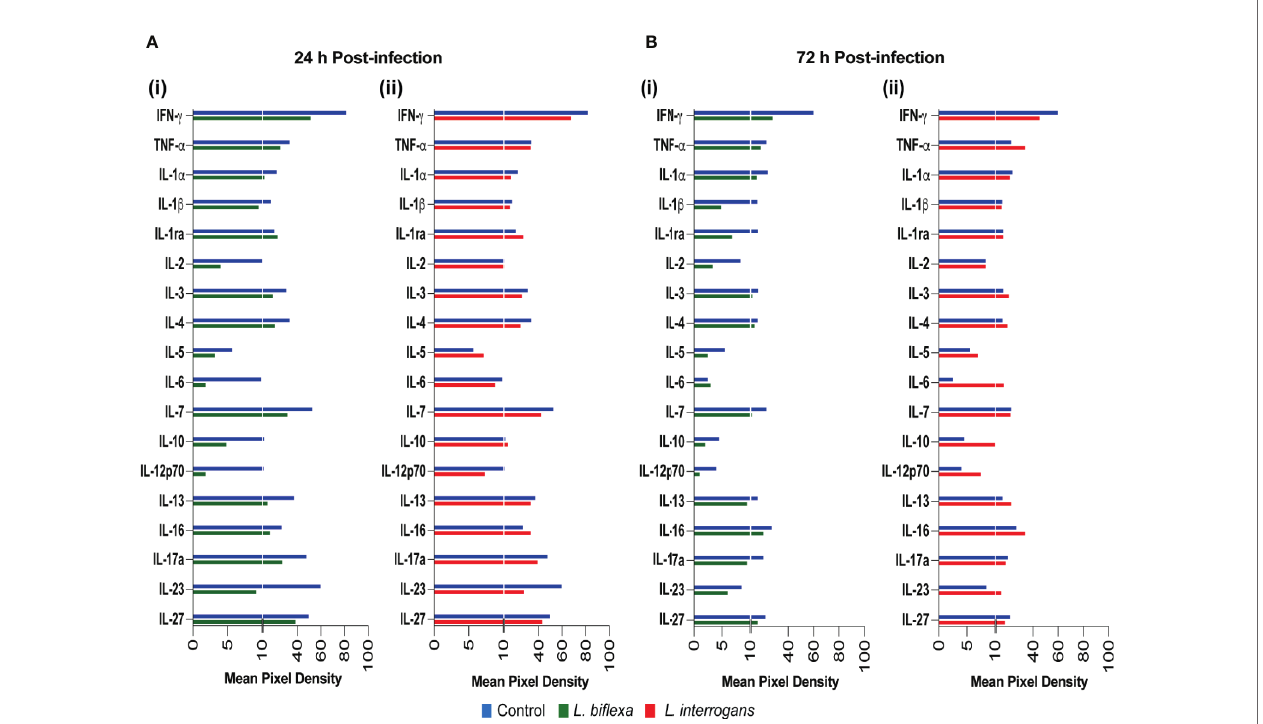
FIGURE 3 | Proteome pro fi ling of cytokines circulating in serum from mice infected with L. interrogans, L. bi fl exa and PBS controls. Detection of cytokine proteins in pooled serum (n=4 mice), represented as mean pixel density at 24h (A) and 72h (B) post infection. Sub-panel (i) depicts representative graphs of L. bi fl exa vs control, whereas (ii) depicts L. interrogans vs control. The chemiluminescence was measured and the mean pixel density value was determined using ImageJ software. The values were normalized by subtracting the background of 3 membranes for each exposure for a total of 3 exposures. Data represents the average pixel density between the two spots for each immune marker after subtraction of the normalized